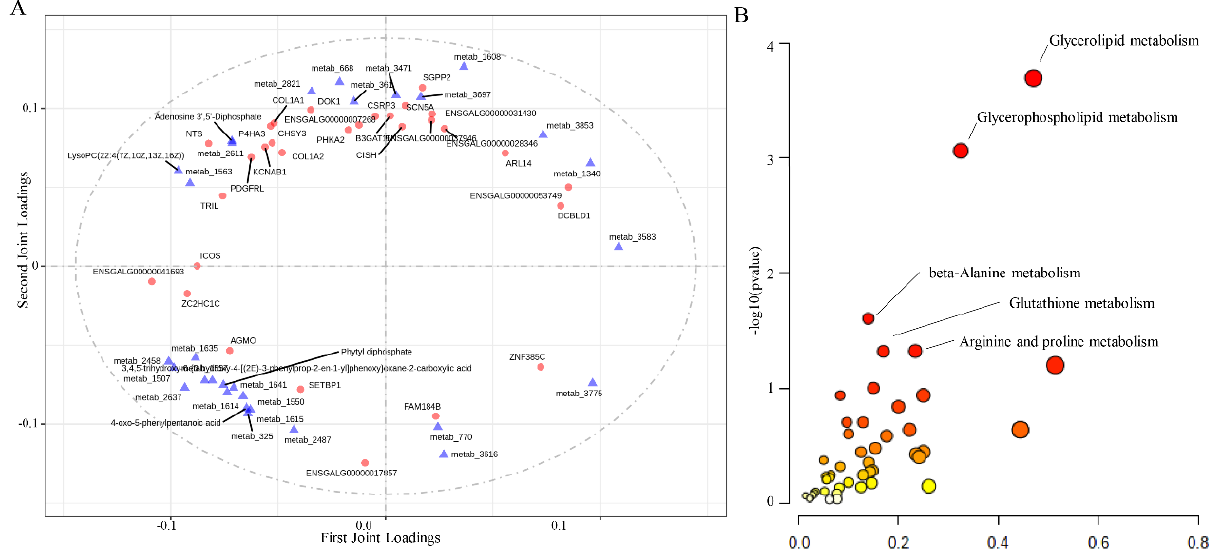
Figure 4. Comparative analysis between transcriptome and metabolome data. ( A ) Comparative analysis between RNA-seq and metabolome data. The X and Y axes refer to the first joint loading and second joint loading, respectively. The absolute value of the number in coordinates indicates the degree of correlation of the two omics. The red dot refers to the gene, and the blue triangle refers to the metabolite. ( B ) Comparative analysis between DEGs and differential metabolites. The X-axis refers to the pathway impact between the two omics. The y-axis refers to − log10 ( p value).